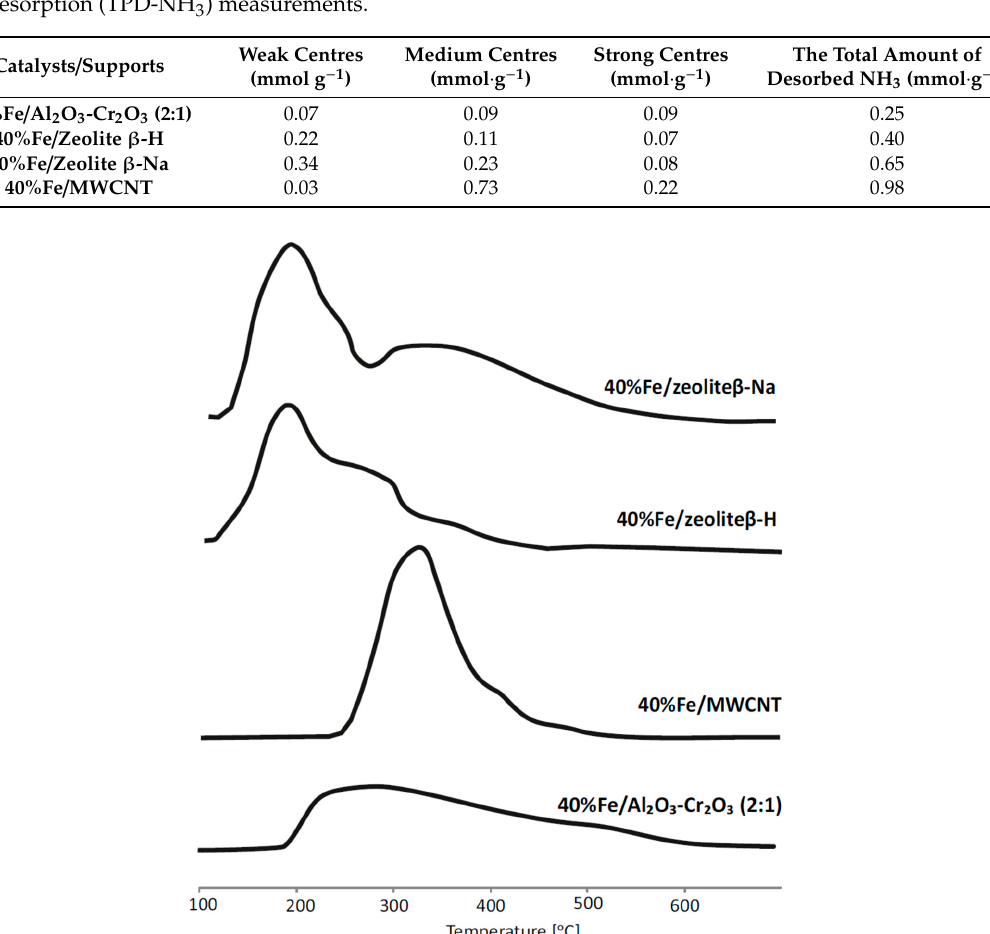
Figure 8. The temperature programmed desorption (TPD-NH 3 ) profiles collected for the reduced catalysts supported on binary oxide, MWCNTs, zeolite β -H -Na and zeolite β -H.